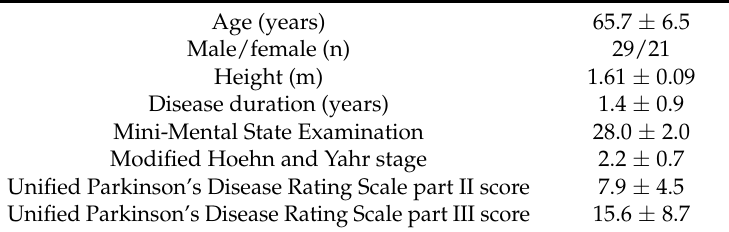
Table 1. Clinical features of patients with Parkinson’s disease ( n = 50).